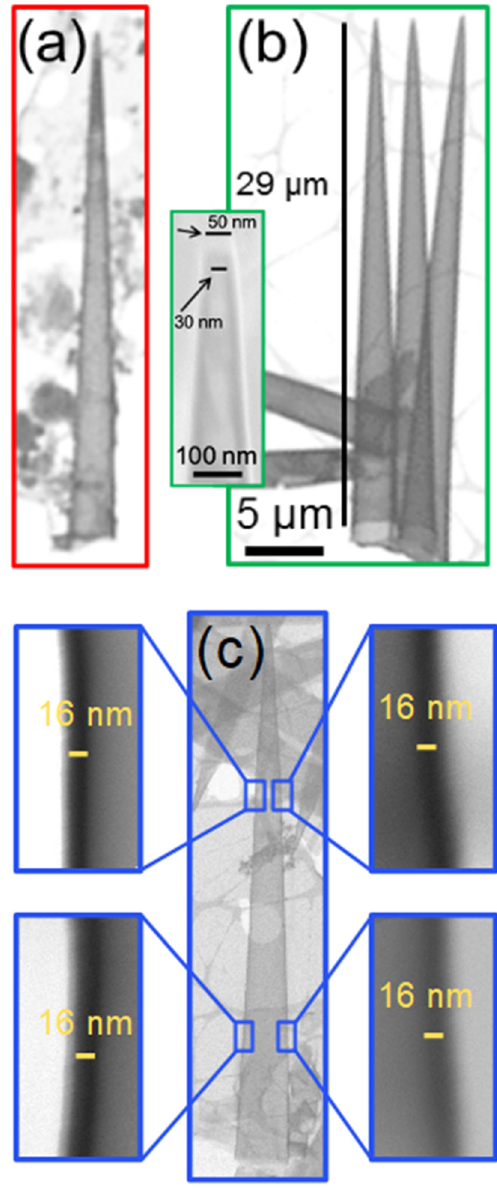
Figure 4. STEM-in-SEM images of ~30 µm long conical Al 2 O 3 ( a ), TiO 2 ( b ), and SiO 2 ( c ) nanotubes with a wall thickness of ~16 nm. The inset in ( b ) shows the open tip of a TiO 2 tubular nanocone (~16 nm wall thickness) in detail. Images with higher magnification in ( c ) demonstrate a homogeneous wall thickness along the entire cone length. The scale bar shown in ( b ) also applies for ( a – c ).